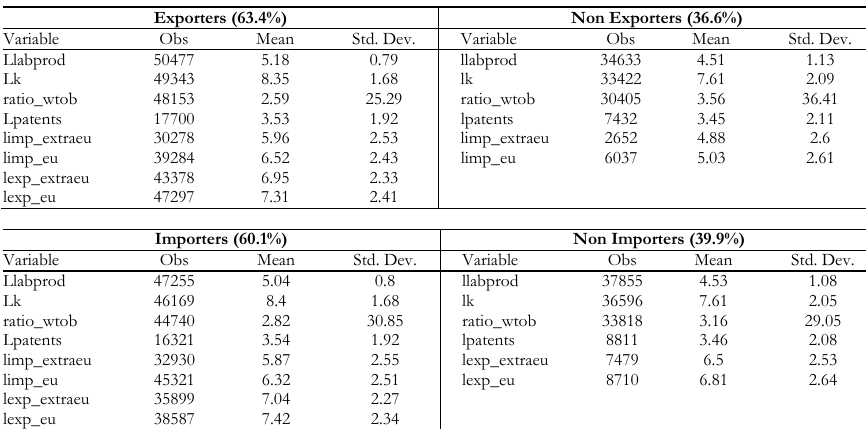
Descriptive Statistics for Exporters versus Non-Exporters, Importers versus Non-Importers